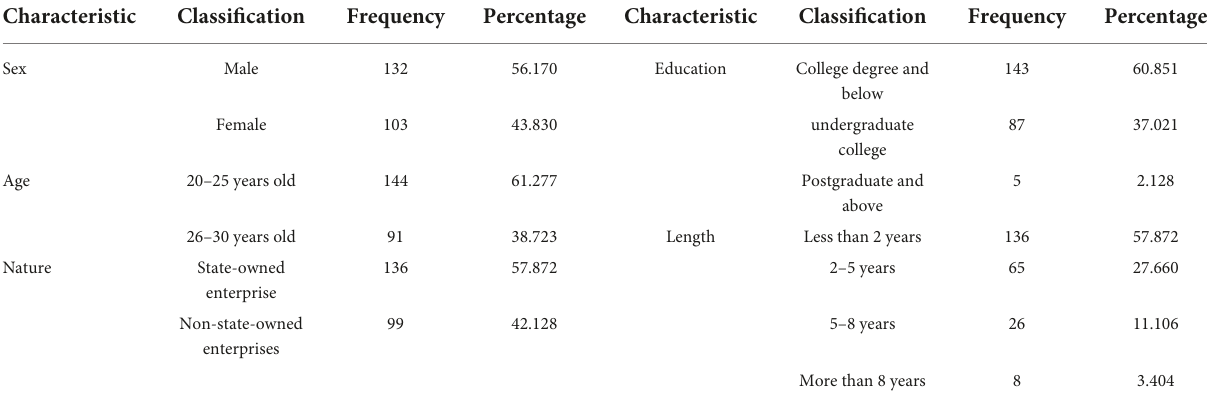
TABLE 2 Descriptive statistics for the